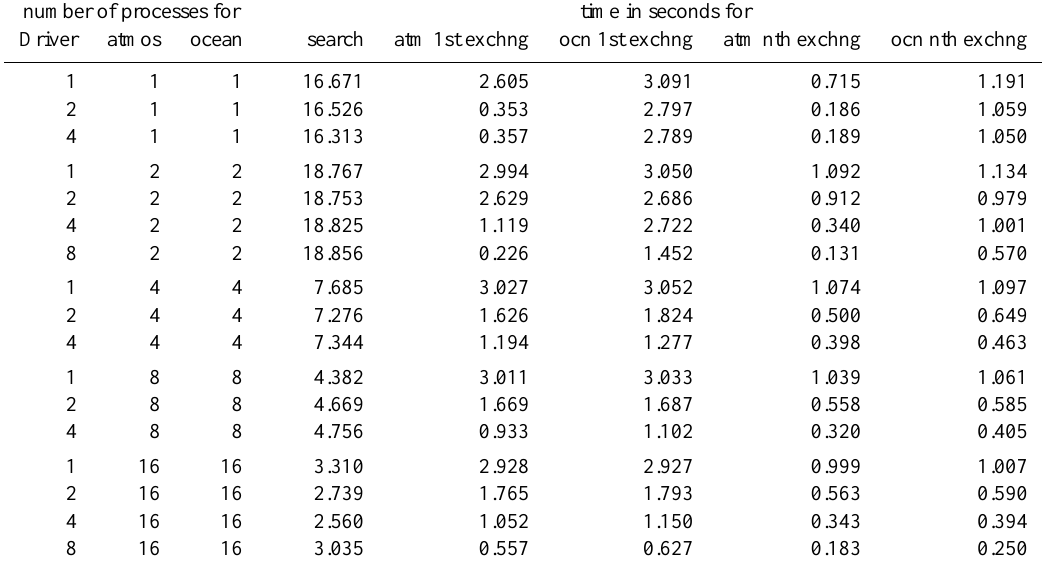
Table 3. As in Table 2 but for 3-D search and exchange.